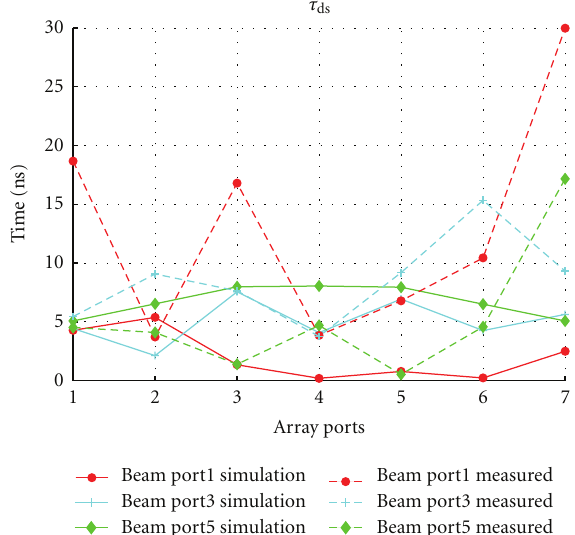
Figure 12: Output delay spread: simulation and measurement.